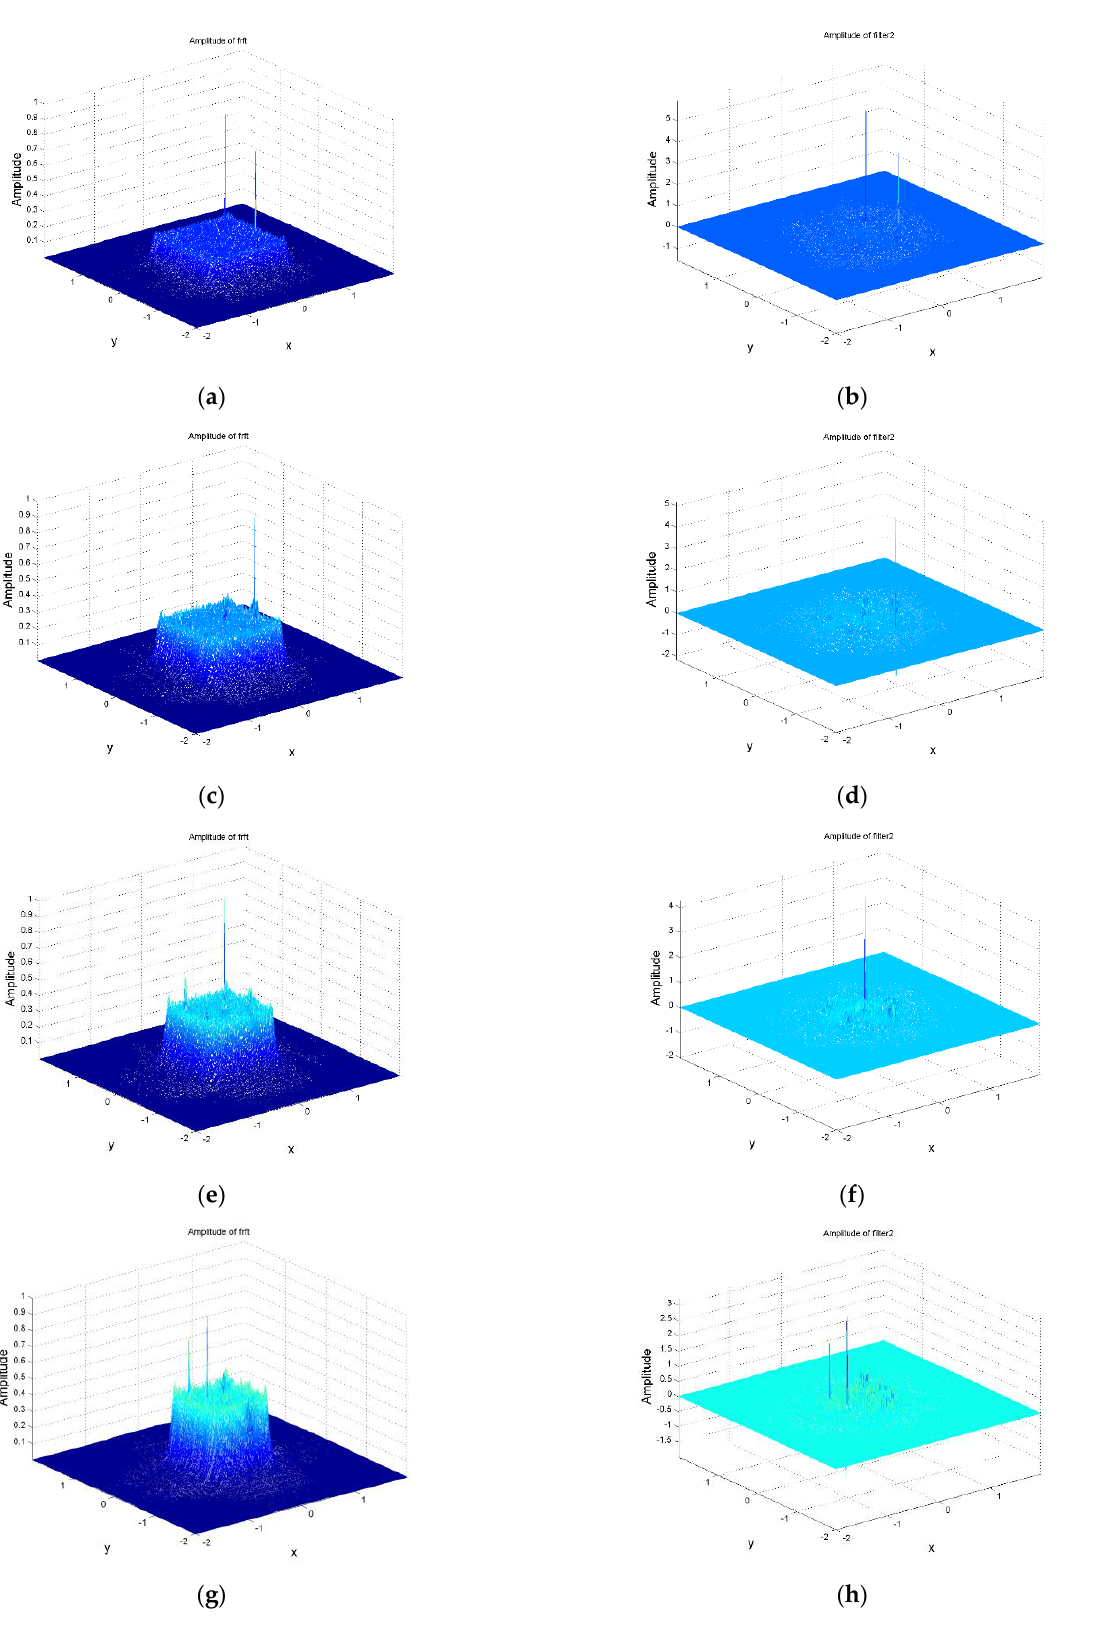
Figure 6. Normalized fractional Fourier spectra F r ( u,v ) (left column) and the corresponding filtered results G ( u,v ) (right column) with the determined best fractional orders: ( a , b ) α best = (0.73, 0.73); ( c , d ) α best = (0.76, 0.76); ( e , f ) α best = (0.79, 0.79); ( g , h ) α best = (0.82, 0.82).